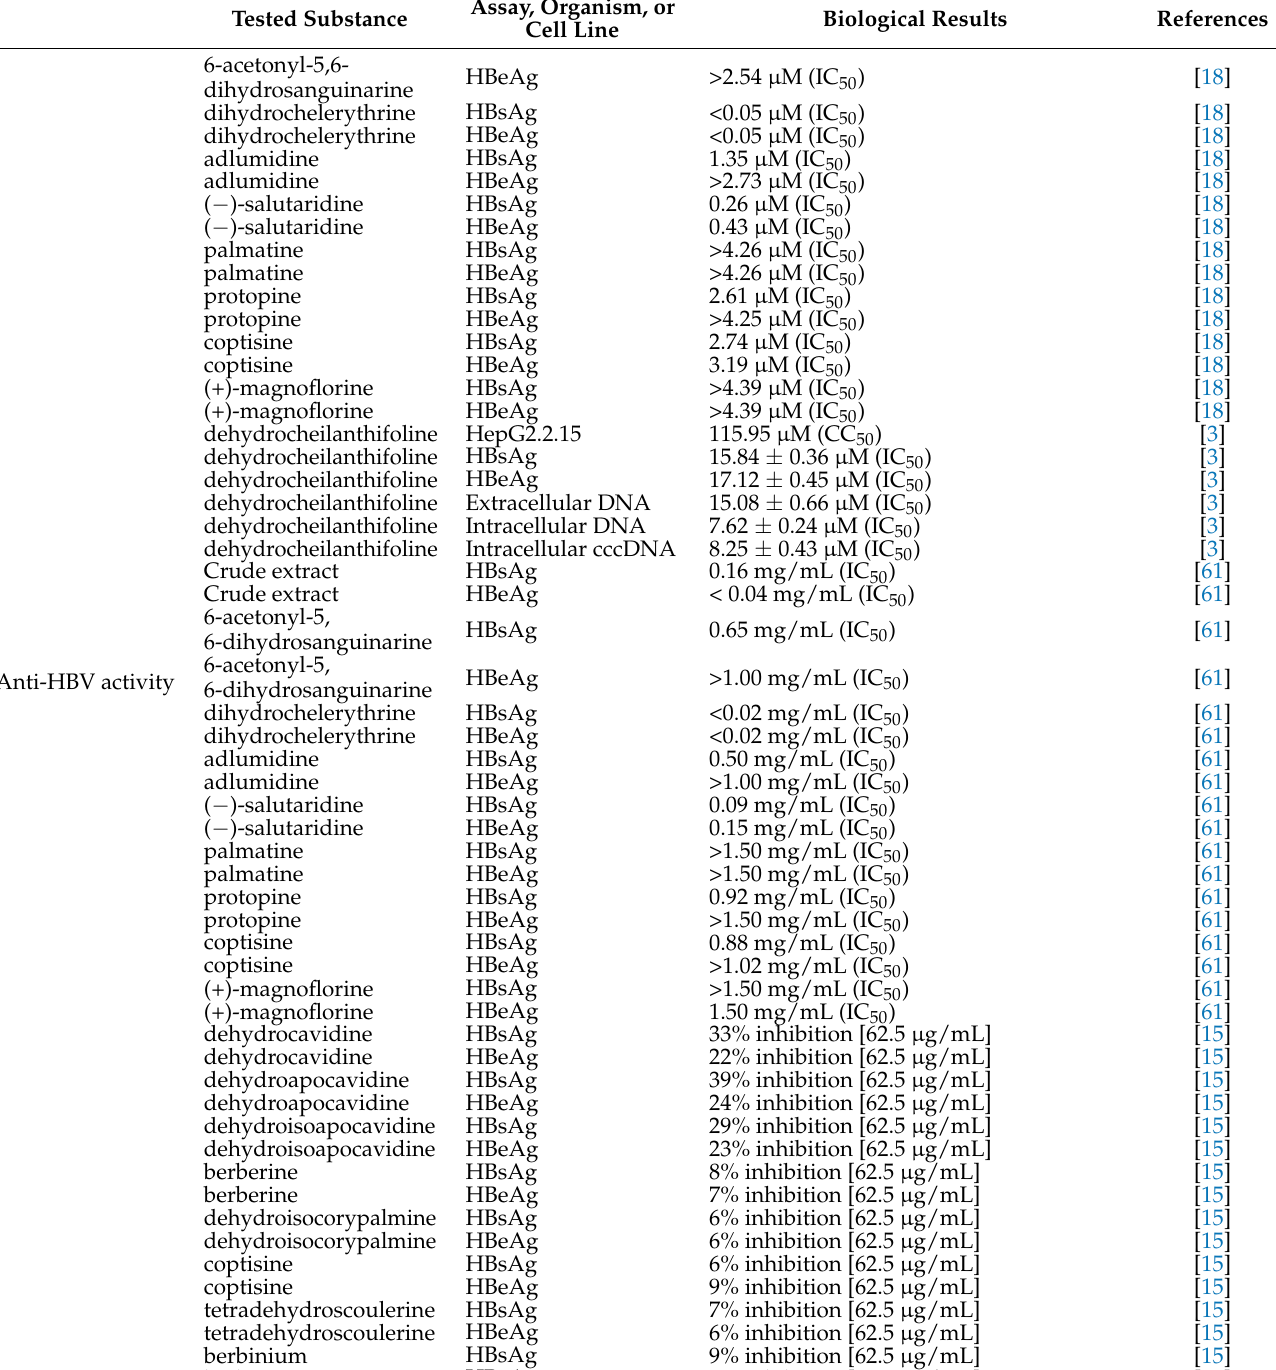
Table 2. Cont. Tested Substance